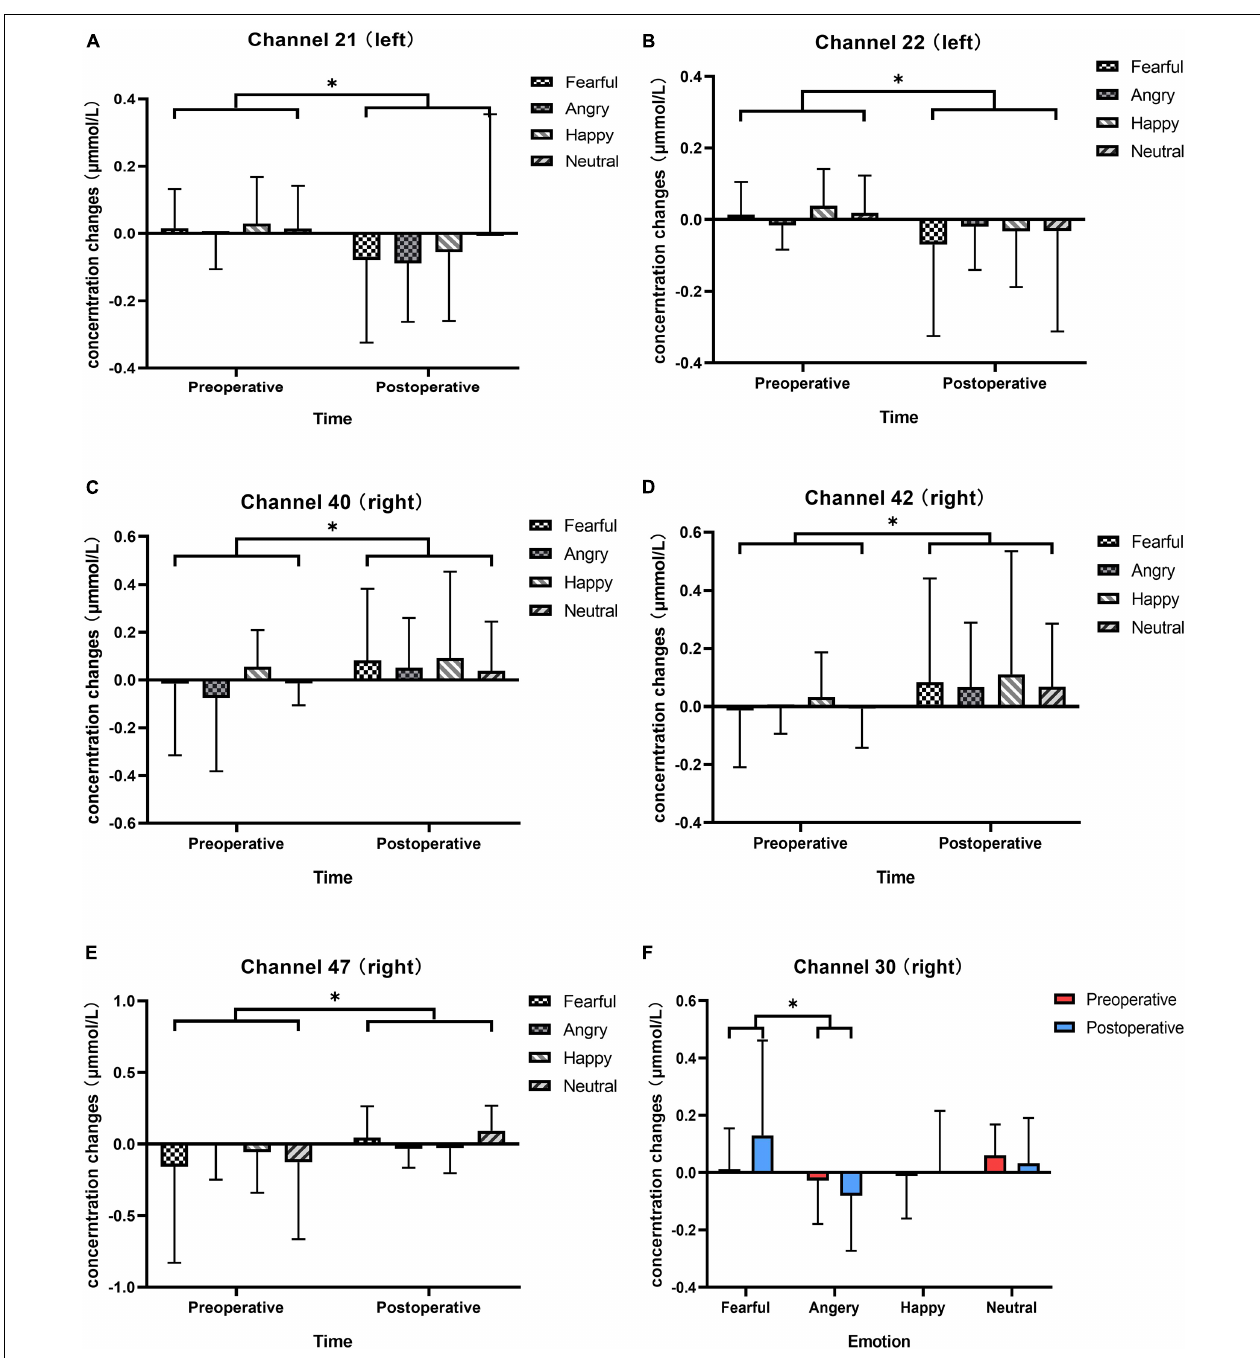
FIGURE 4 | Changes in the responses of cortical oxyhemoglobin to four vocal emotional stimuli (the white grid pattern represents fearful emotion, the gray grid pattern represents angry emotion, the white diagonal pattern represents happy emotion, and the gray diagonal pattern represents neutral emotion) in the two-period test (red represents the preoperative test, blue represents the postoperative test). The six subplots show channels 21, 22 (located in the left pre-motor and supplementary motor cortex), 30 (located in the right supramarginal gyrus of Wernicke’s area), 40, 42 (located in the middle temporal gyrus), and 47 (located in the superior temporal gyrus). (A,B) In channels 21 and 22 (located in the left pre-motor and supplementary motor cortex), there is a significant difference in cortical activation elicited by vocal emotional stimulation in the preoperative and postoperative tests. (C,D) In channels 40 and 42 (located in the right middle temporal gyrus), there is a significant difference in cortical activation elicited by vocal emotional stimulation in the preoperative and postoperative tests. (E) In channel 47 (located in the right superior temporal gyrus), there is a significant difference in cortical activation elicited by vocal emotional stimulation in the preoperative and postoperative tests. (F) In channel 30 (located in the right supramarginal gyrus of Wernicke’ s area), cortical activation elicited by fear is significantly different than that elicited by anger. ∗ p < 0.05.